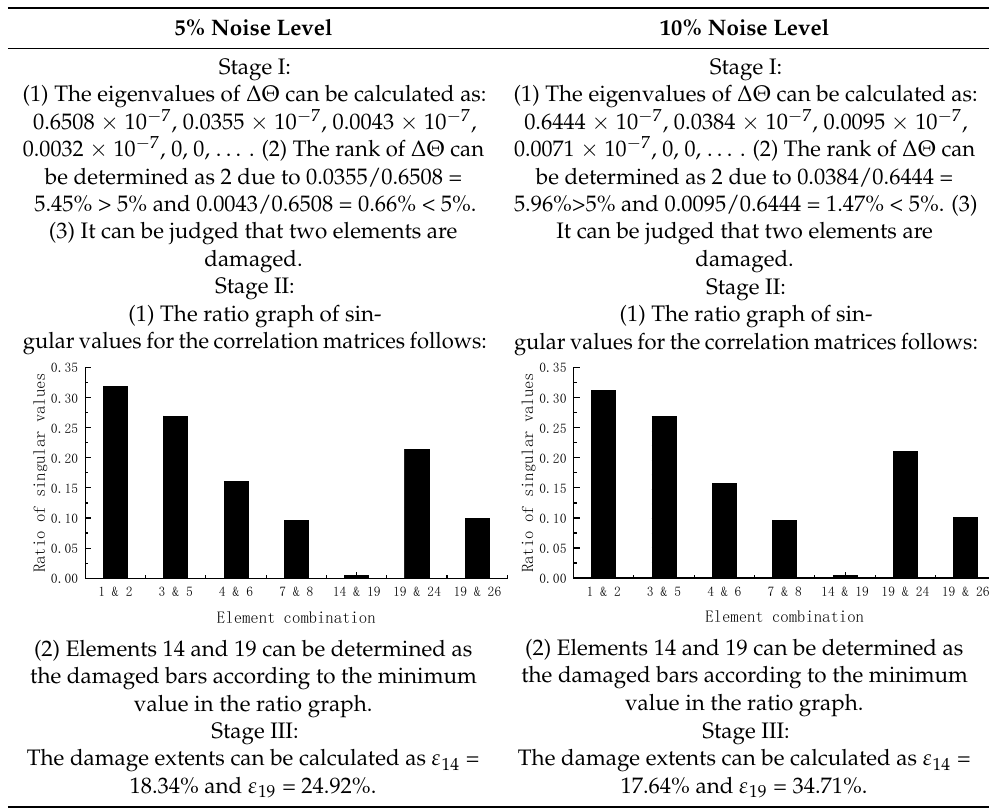
Table 5. The damage assessment results by the proposed multiple-stage dynamic flexibility analysis method when elements 14 and 19 are damaged.